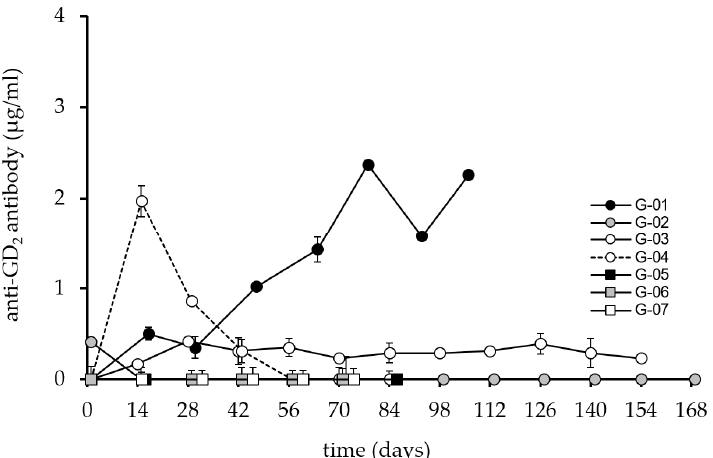
Figure 4. Induction of anti-GD2 humoral response after vaccination with ganglidiomab over time. The anti- GD2 response serum levels were analyzed by ELISA following the procedure described previously for the seven patients immunized with the ganglidiomab vaccine. The graphs indicate the mean value for each patient at each visit. The standard deviation (error bar) is small and can only be seen in some of the values presented in the